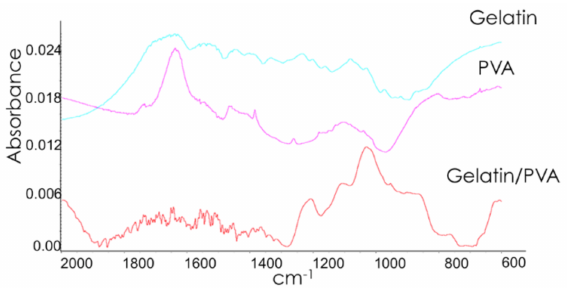
Figure 4. FT-IR spectra of PVA, gelatin and composite gelatin/PVA